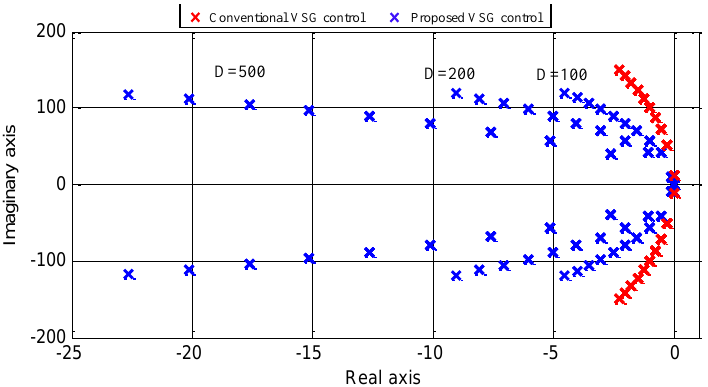
Figure 11. Root locus plot of the converters when increasing the damping factor.